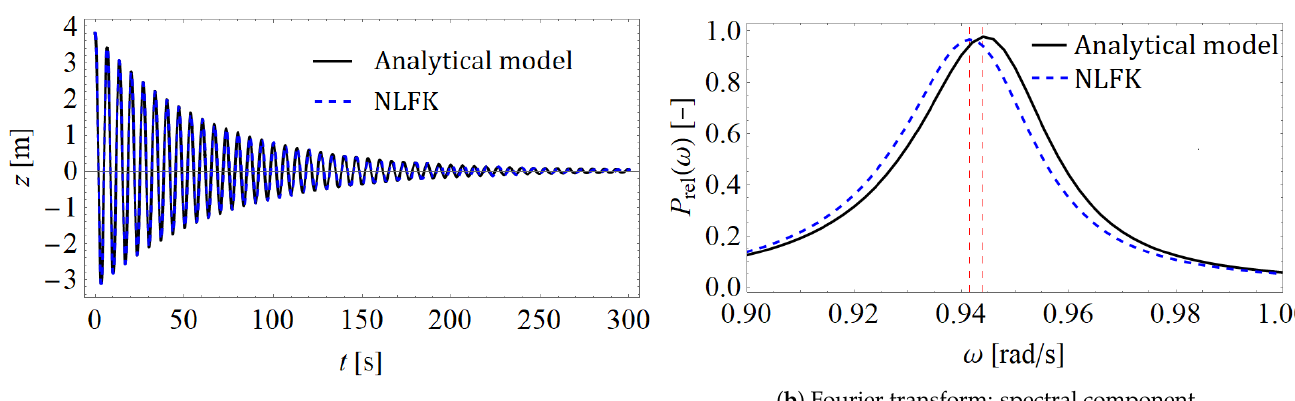
Figure 14. ( a ) Free response and ( b ) its Fourier transform.